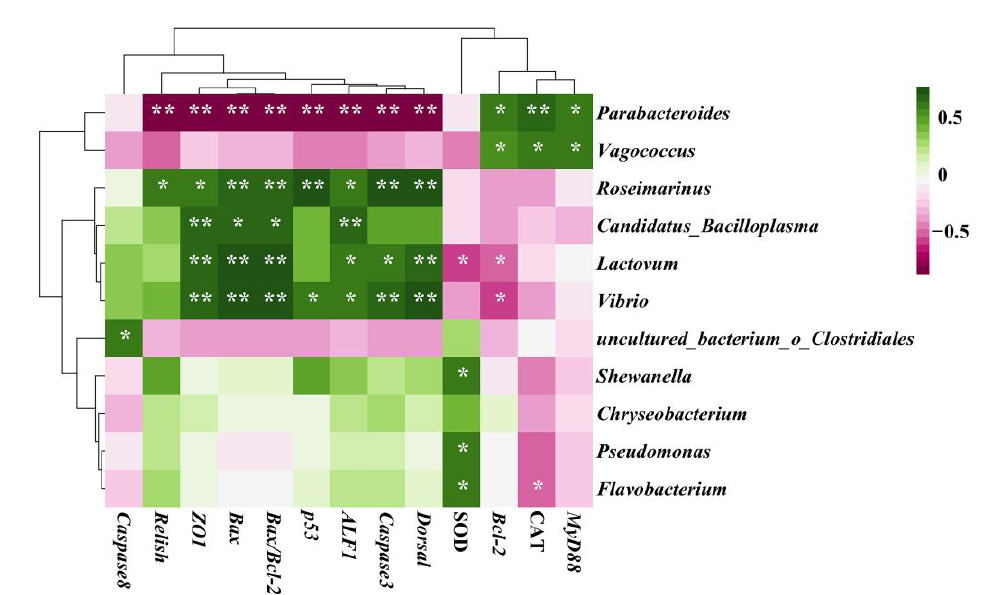
Figure 9. Correlations between intestinal genera and crab gut health. The asterisks “*” indicate statistical significance compared to the control group (* p < 0.05 and ** p < 0.01).